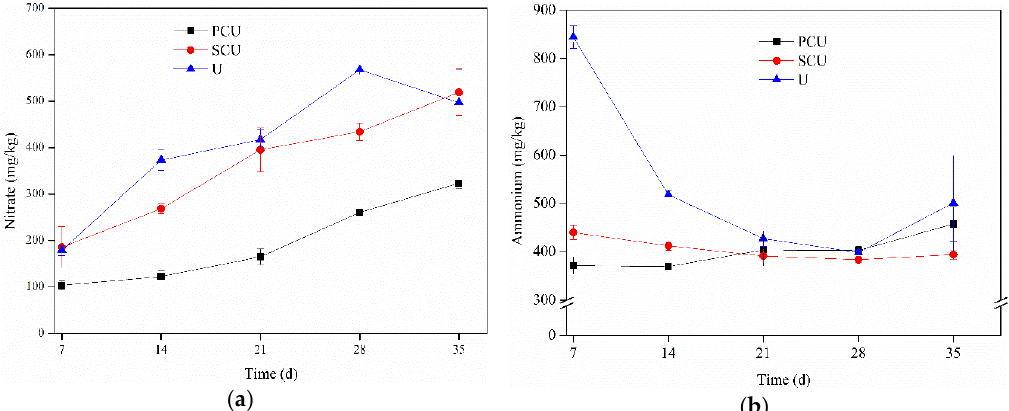
Figure 1. Dynamic changes of ( a ) nitrate and ( b ) ammonium in black soils.